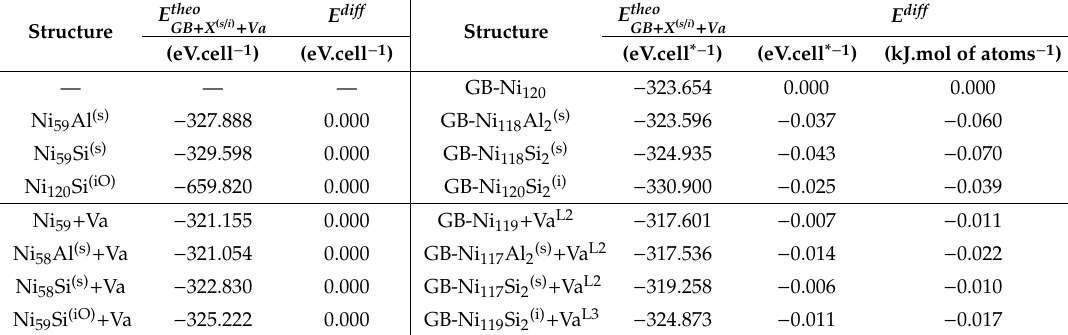
and the di ff erence Table 10. Theoretical total energies of studied structures E theo GB + X ( s / i ) + Va between the total energies calculated ab initio and theoretical total energies (calculated from the particular contributions) E dif f for Ni 59 Al (s) , Ni 59 Si (s) , Ni 120 Si (iO) , Ni 59 + Va, Ni 58 Al (s) + Va, Ni 58 Si (s) + Va, Ni 59 Si (iO) + Va, GB-Ni 120 , GB-Ni 118 Al 2(s) , GB-Ni 118 Si 2(s) , GB-Ni 120 Si 2(i) , GB-Ni 119 + Va L2 , GB-Ni 117 Al 2(s) + Va L2 , GB-Ni 117 Si 2(s) + Va L2 and GB-Ni 119 Si 2(i) + Va L3 structures. In case of the structures with GB, the energies E theo are related to one GB and X. From this reason, these energies are GB + X ( s / i ) + Va comparable with those of structures without